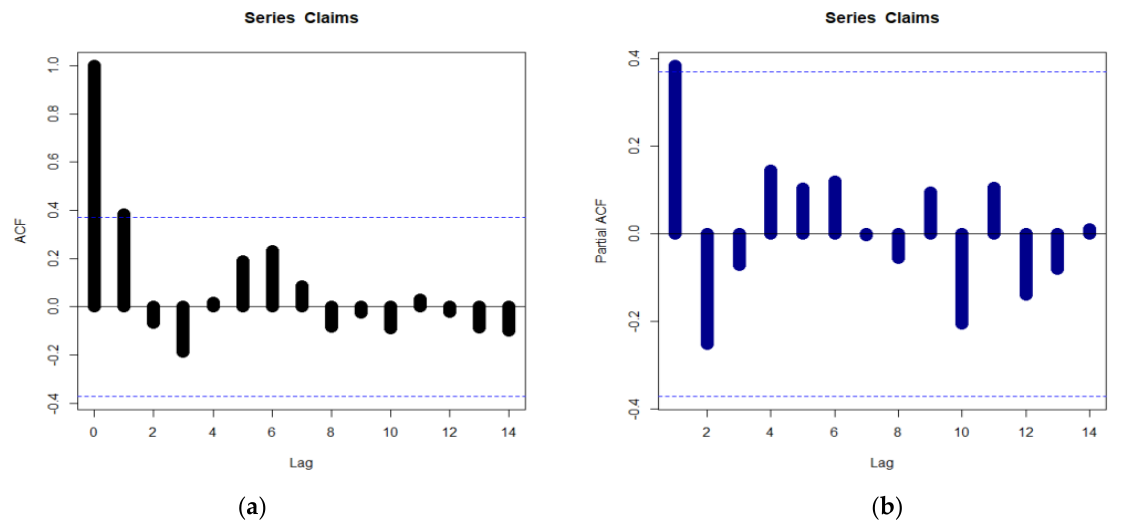
Figure 11. ( a ) The ACF plot for the insurance claims data, and ( b ) the partial ACF plot for the insurance claims data.